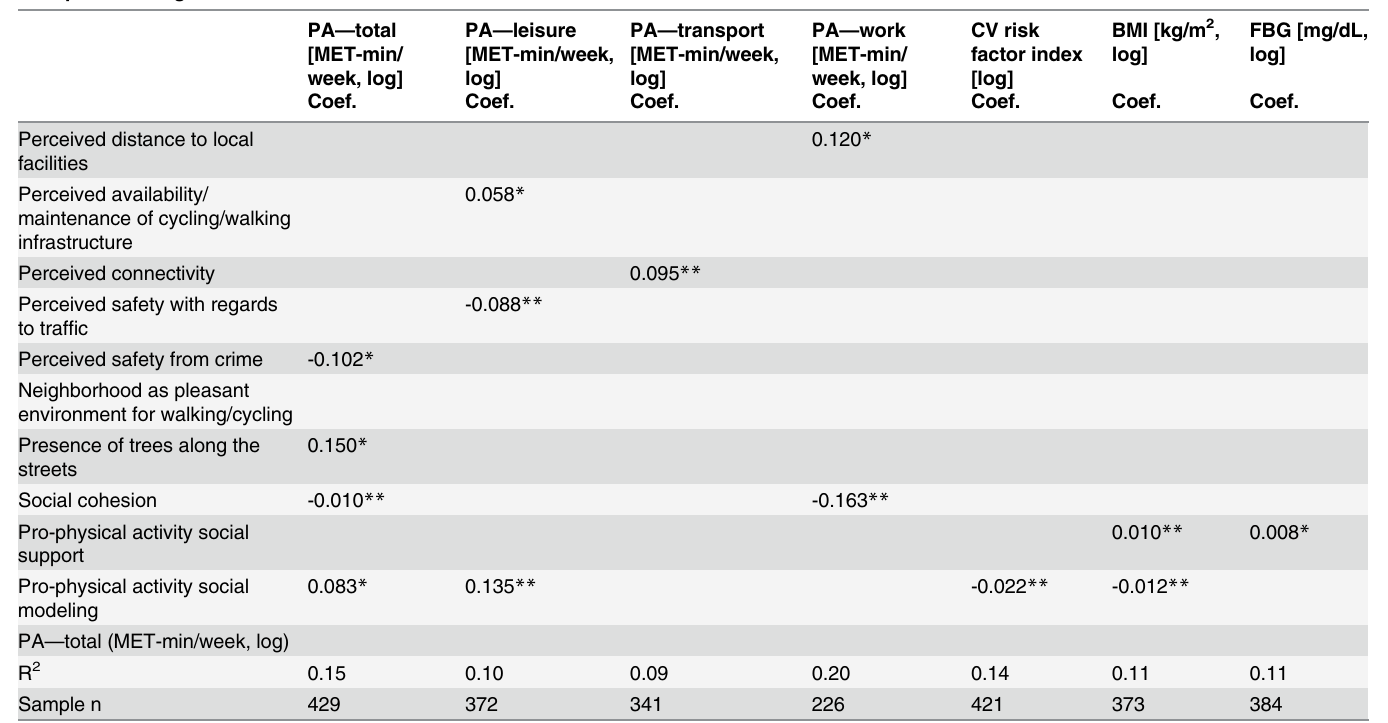
Table 4. Cardiovascular risk factors/behaviors by built and social residential characteristics as well as individual characteristics — final stepwise multiple linear regression model results — Men a